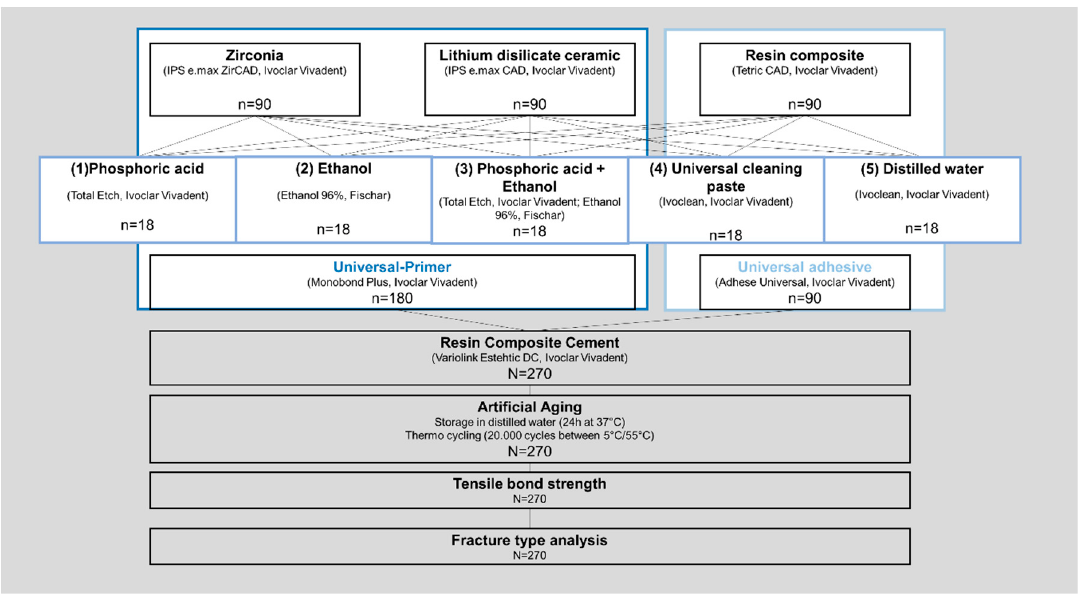
Figure 1. Study design: impact of cleaning protocol on the tensile bond strength between a resin composite cement and three different computer aided design/computer aided manufacturing (CAD/CAM) materials. Table 1. List of the materials used according the product name, manufacturer, chemical composition and Lot No.